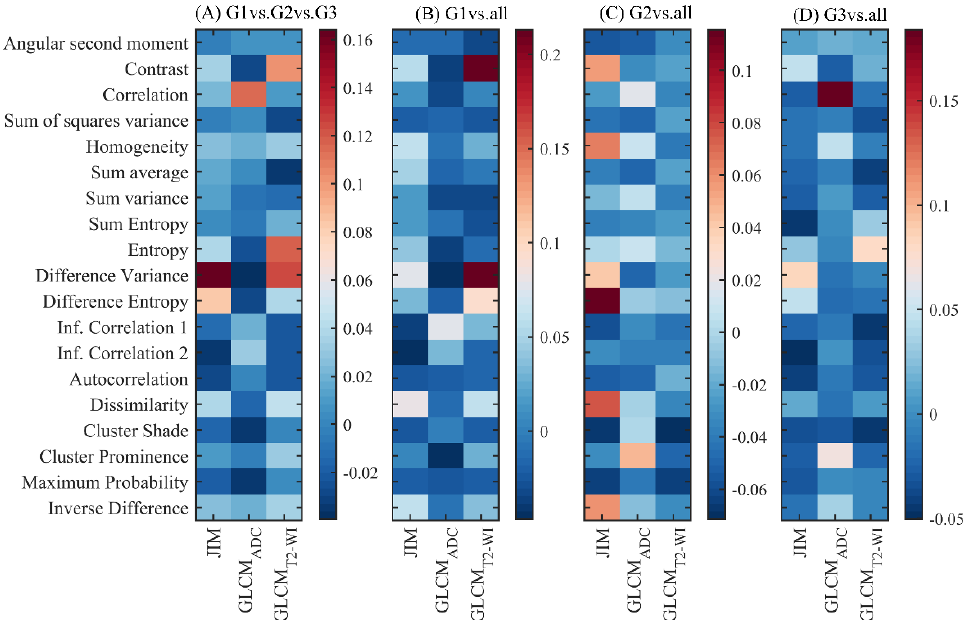
Figure 4. Importance of individual features for predicting GS groups using the RF classifier. Positive and negative values correspond respectively to predictive and non-predictive features.